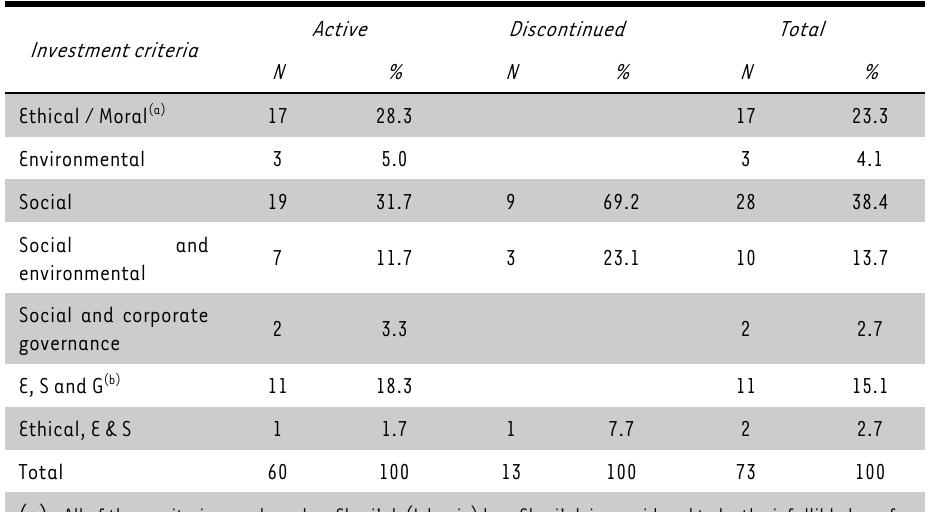
Investment criteria used by South Africa RI asset managers over the period 1 June 1992–31 December 2012